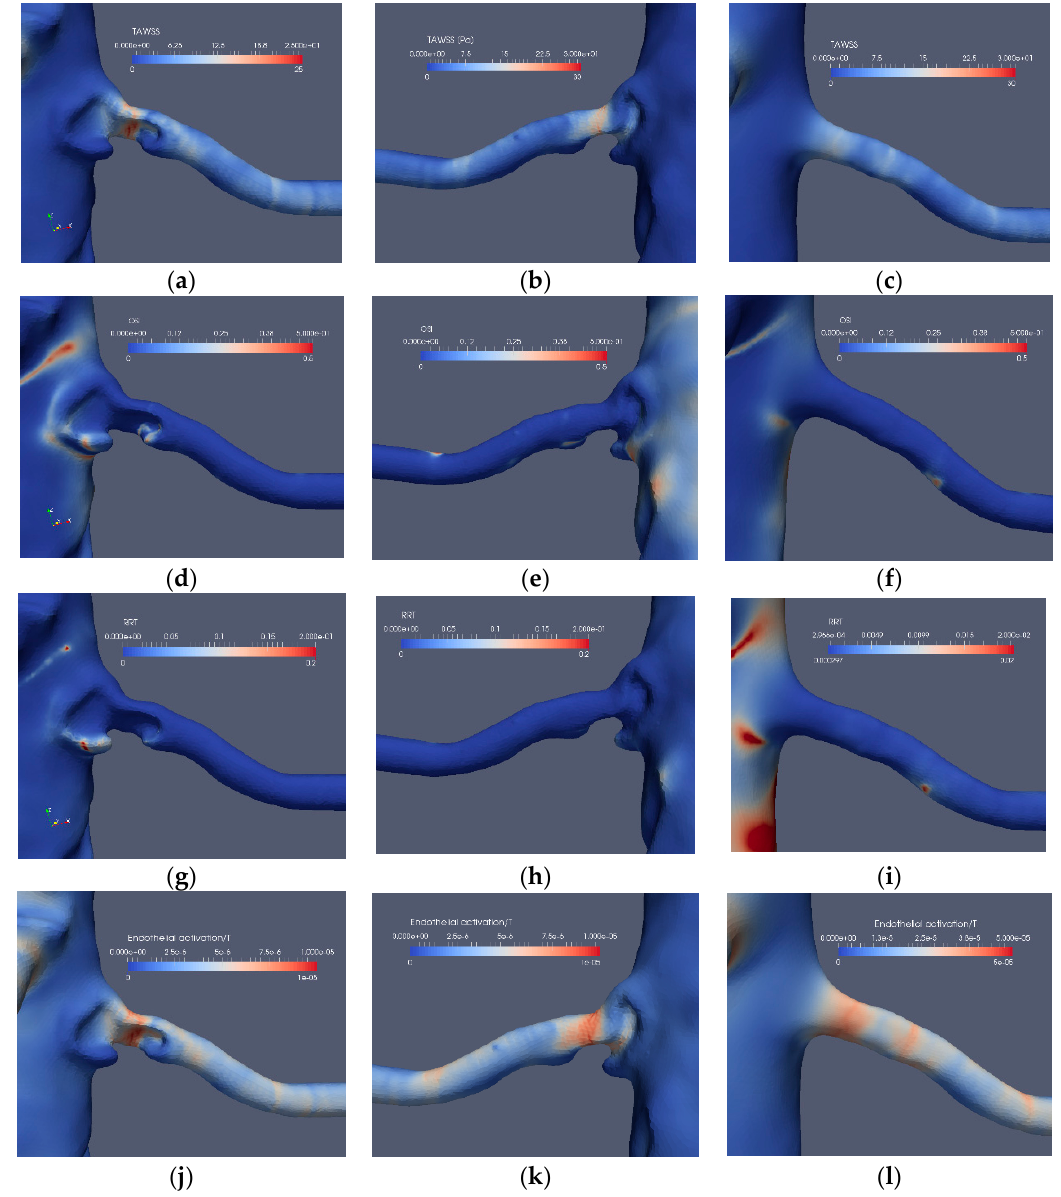
Figure 10. The stenosis indicators for Case2.1 (stenoted) and Case2.3 (reconstructed and smoothed): The left and right frames show the left renal artery from the anterior view, whereas the mid-frames show the same artery from a posterior view for TAWSS ( a – c ), OSI ( d – f ), RRT ( g – i ) and EAI ( j – l